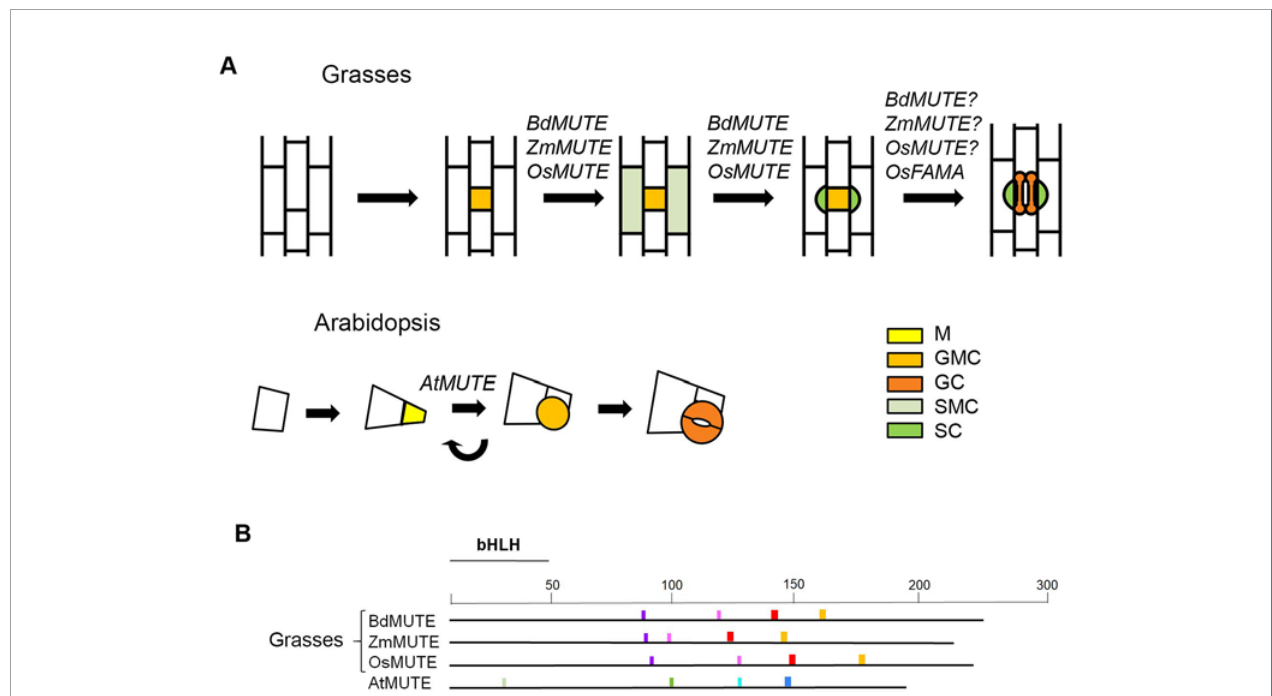
FIGURE 1 | Role of MUTE orthologues of grasses and AtMUTE during stomatal development. (A) Stomatal development in grasses starts with an asymmetric division that produces a guard mother cell (GMC). Before GMC division, cells from fi les on either side of the GMC assume subsidiary mother cell (SMC) identity. SMCs then divide asymmetrically to produce subsidiary cells (SCs) in direct contact with the GMC. Only when the GMC is fl anked by the two SCs, a symmetric cell division produces the two dumbbell-shaped guard cells (GCs). Grass MUTE genes specify SMC identity. They also appear to control the fate of the GMC, with the action of BdMUTE being less severe than those of ZmMUTE and OsMUTE . OsFAMA regulates the last stage of stomatal development. In Arabidopsis, a protodermal cell divides asymmetrically to produce a meristemiod (M) and a larger pavement cell. Ms usually reiterate asymmetric division several times, in an inward spiral, until they assume GMC identity. The GMC divides symmetrically to produce the two kidney-shaped GCs. AtMUTE regulates the transition of the M to GMC. (B) Schematic diagram of potential mobility motifs in the MUTE protein sequences. Conserved motifs in grass MUTE proteins could promote the intercellular movement, from the GMC to SMC, of these transcriptional factors. In contrast, the motifs conserved in AtMUTE could prevent its intercellular movement. The different-coloured boxes represent different motifs. These motifs are conserved among grasses but not in eudicots or vice versa, or are different between grasses and eudicots. Arabidopsis motifs are shown as an example of eudicot ones. The position of the bHLH domain is indicated. GC, guard cell; GMC, guard mother cell; M, meristemoid. SMC, subsidiary mother cell; SC, subsidiary